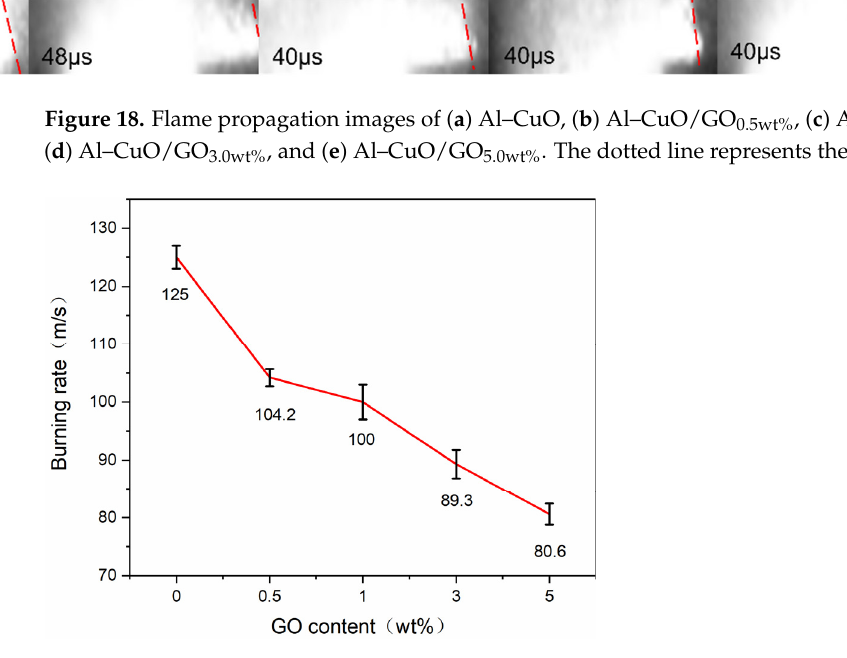
Figure 19. Burning rate of Al–CuO/GO MICs with different GO contents.